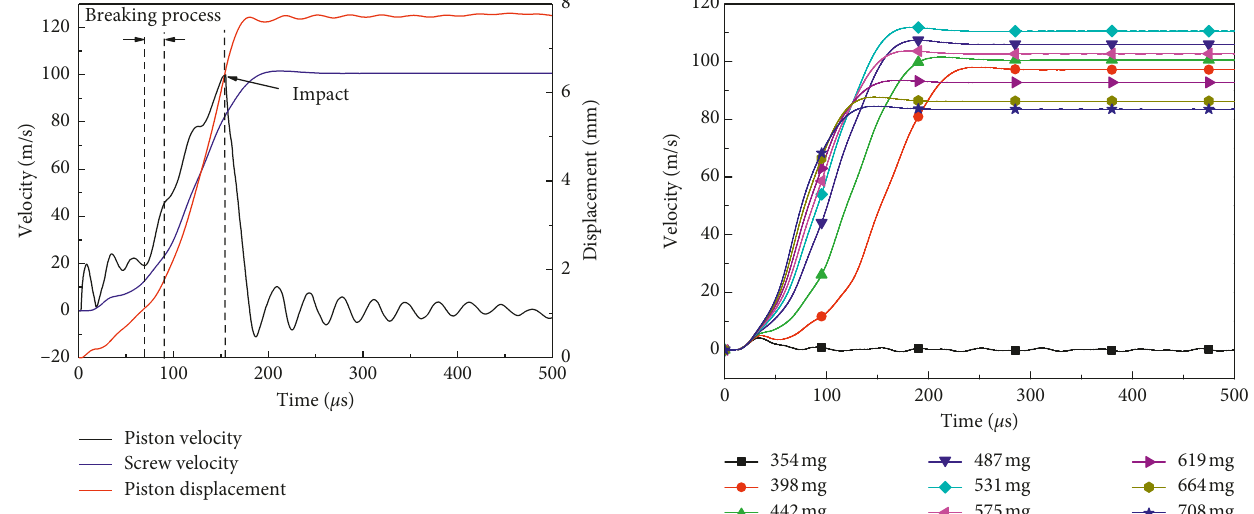
Figure 16: Velocity histories of the piston and screw at 442mg charge amount.